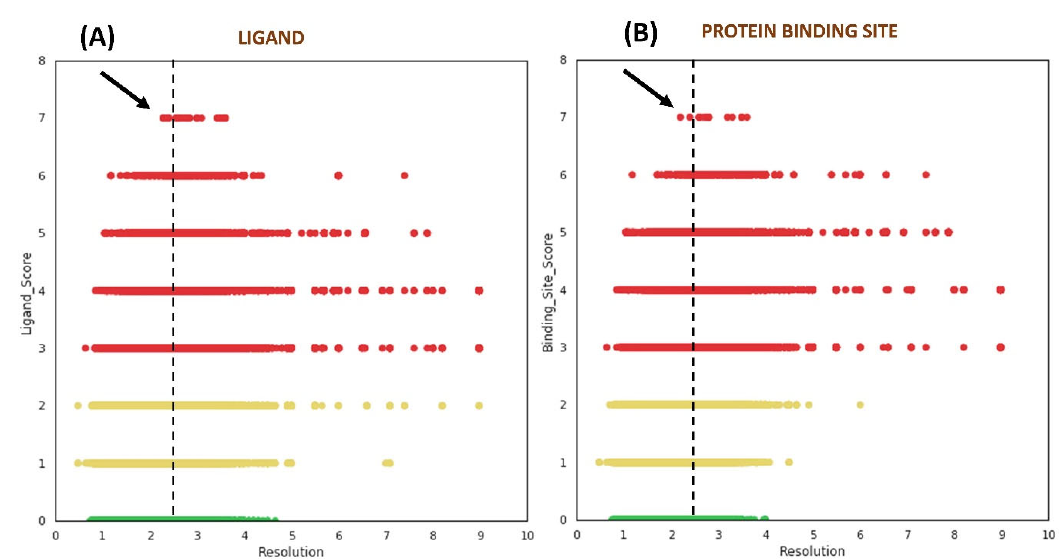
Figure 3. Distribution of quality scores obtained from VHELIBS vs. resolution (Å) of the corresponding structure. ( A ) Quality score of ligands vs. resolution. ( B ) Quality score of protein binding sites vs. resolution. The green, yellow, and red circles represent ‘Good’ (score = 0), ‘Dubious’ (0 < score ≤ 2), and ‘Bad’ (score > 2) categories, respectively. The vertical dashed lines in both the plots are drawn at 2.5 Å, which highlight some of the structures with the worst local quality scores (indicated by black arrows) that are solved at a resolution better than 2.5 Å. Each plot contains 276,377 data points.